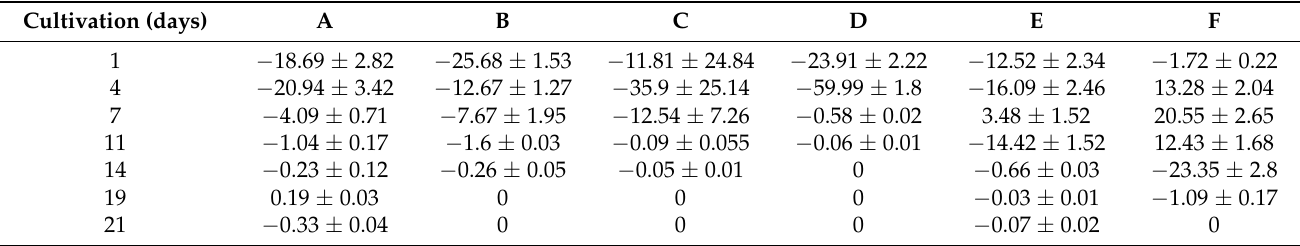
Table 2. Variations in chlorophyll a increment, respectively. To the A, B, C, D, E, and F treatments we added Fe 3+ , Al 3+ , 3 mol/L zinc (Zn 3 ), 10 mol/L zinc (Zn 10 ), Eucalyptus leaves (EL), and pure water, respectively. There were significant differences among treatments and culture days, respectively ( p < 0.05).